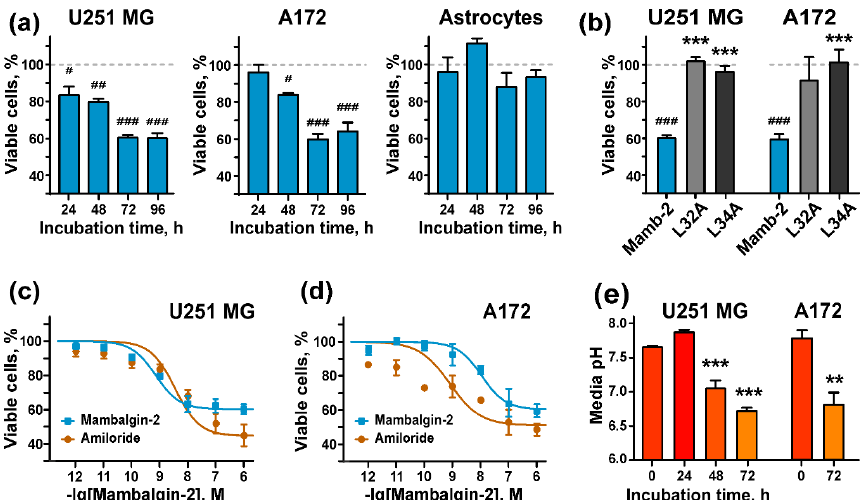
Figure 4. Mambalgin-2 influence on growth of U251 MG and A172 glioma cells and normal astrocytes: ( a ) 1 µ M mambalgin-2 e ff ect on U251 MG, A172 cells and astrocytes proliferation during di ff erent